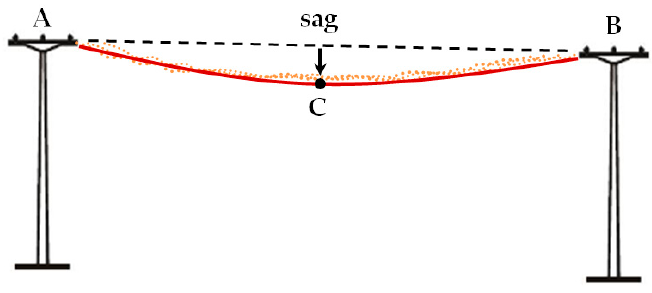
Figure 10. Schematic of line shape and parameters (sag).